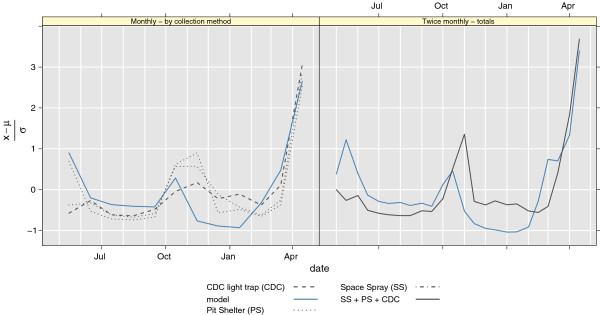
Modeled and observed variations in An. arabiensis . The left panel shows catches broken down to catch method (grey dotted lines), and modelled An. arabiensis. The right panel shows modelled mosquitoes and total twice monthly catches (data from FEK2012).